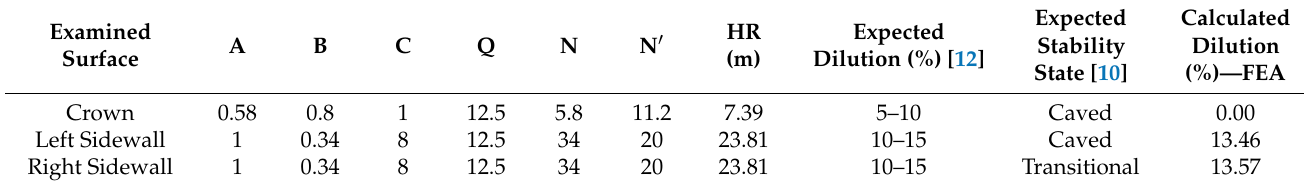
Figure 6. Case study #12: “Yielded Elements” distribution. Table 6. Case study #12: Stability parameters and final results. Table 6. Case study #12: Stability parameters and final results.